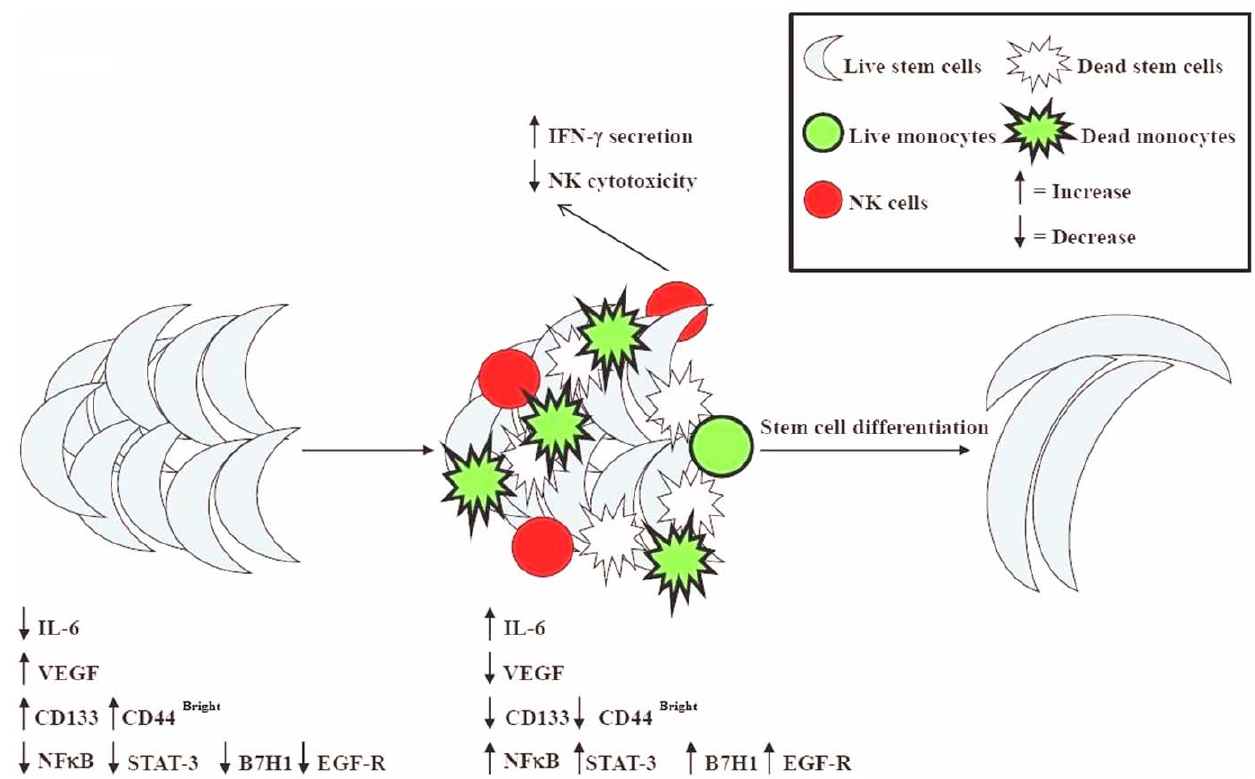
Figure 10. Schematic representation of hypothetical model of oral cancer stem cell or untransformed primary stem cell differentiation by NK cells and monocytes. Interaction of cancer stem cells or primary untransformed stem cells with monocytes and NK cells results in the loss of NK cell cytotoxicity due partly to the induction of resistance of cancer stem cells or primary stem cells by monocytes and indirectly by monocytes serving as targets of NK cells [36], thereby, protecting the stem cells from lysis by the NK cells. Loss of NK cell cytotoxicity by monocytes and gain in secretion of IFN- c results in a significant induction of transcription factors, cytokines and growth factors in stem cells and differentiation of stem cells.